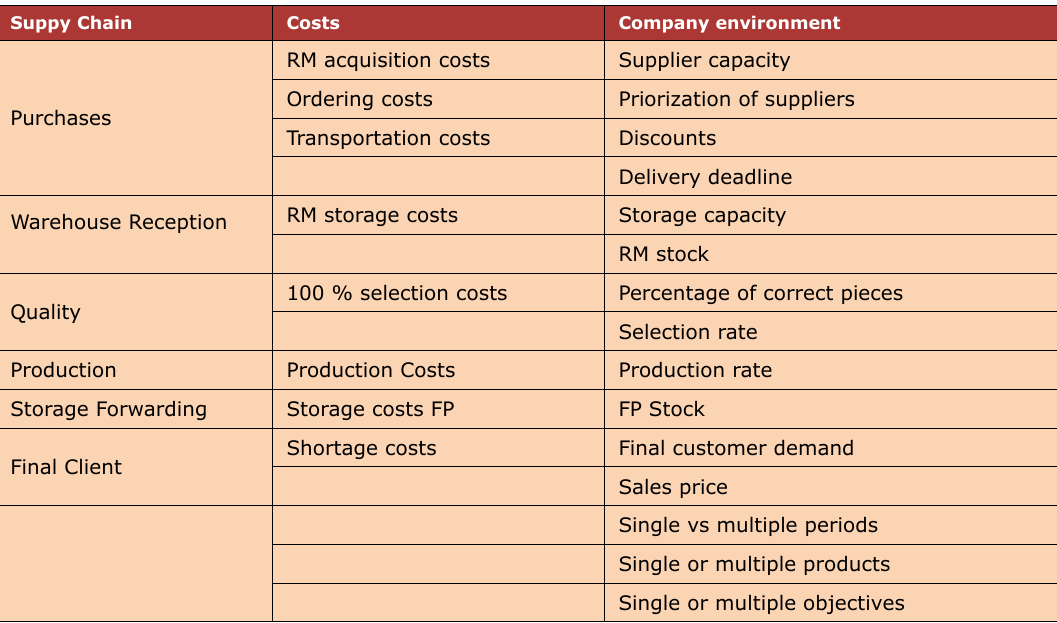
Table 2. Format for calculating characteristics indicator included in